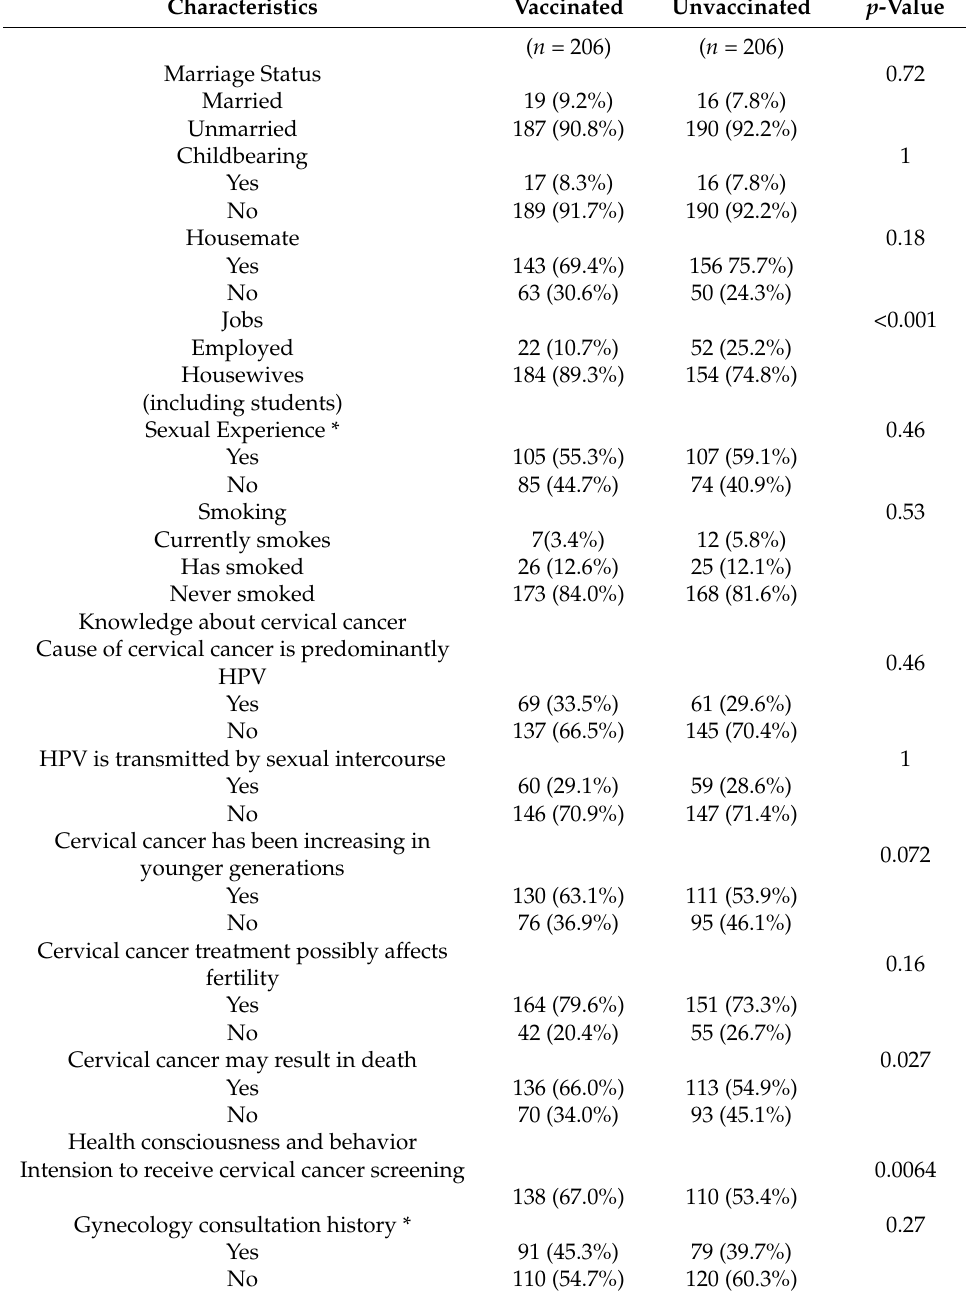
Table 2. Internet survey results on characteristics and the health consciousness and